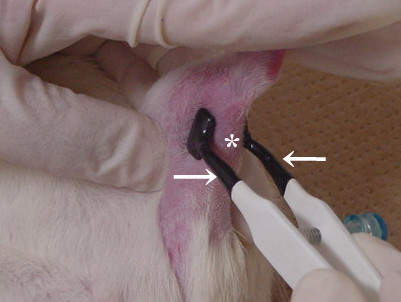
Transcutaneous in vivo electroporation for skeletal muscle. After the injection of 25 μg of plasmid into the gastrocnemius muscle, transcutaneous in vivo electroporation was performed via the skin of the calf to drive the gene transfer. The conditions were 8 pulses of 100 V, 50 msec. *, plasmid-injected area; arrows, electrodes.